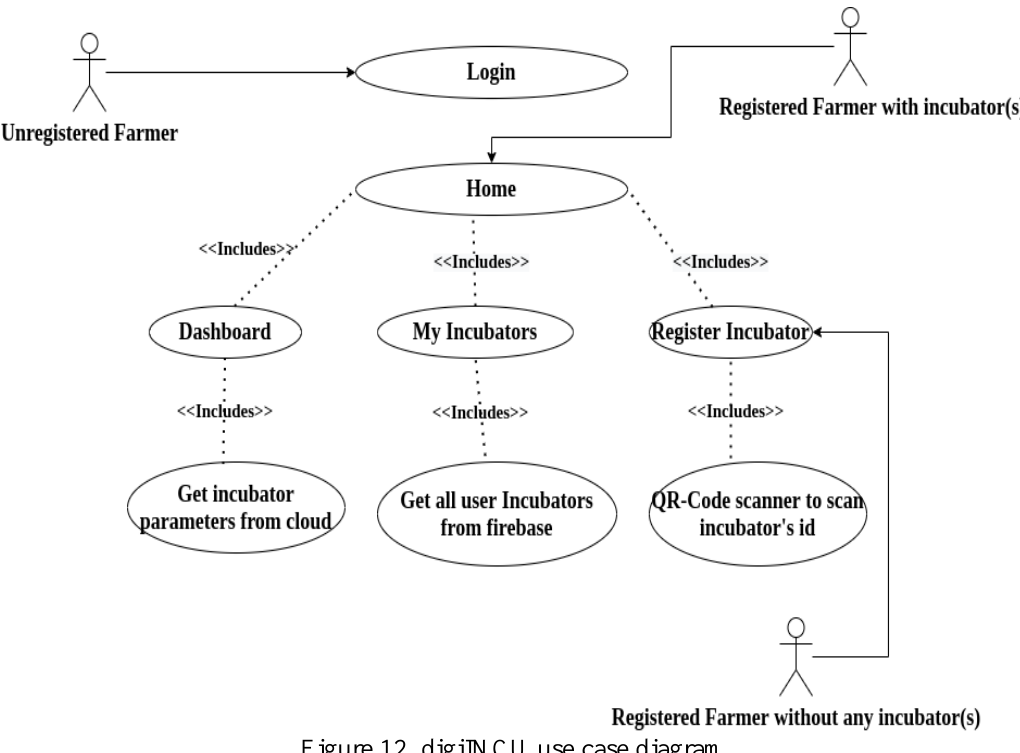
Figure 12. digiINCU use case